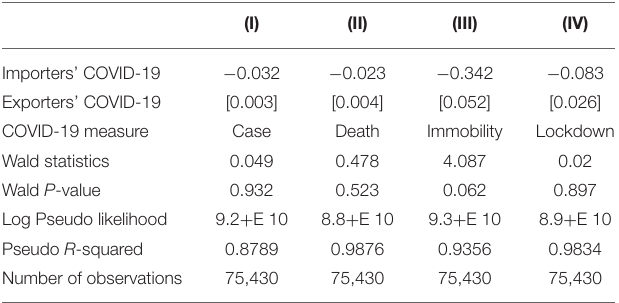
TABLE 7 | Baseline estimation